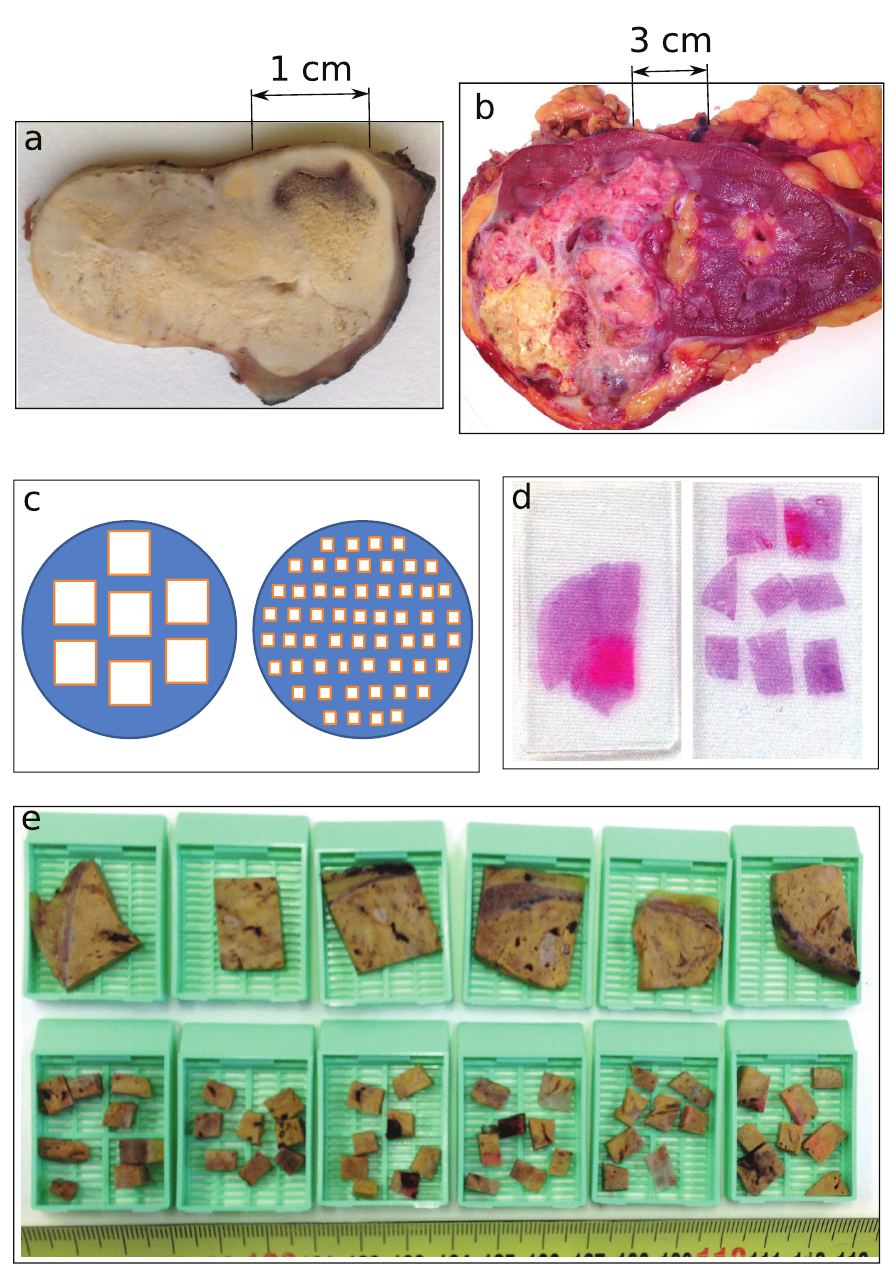
Figure 1. ITH in CCRCCs may be hidden ( a ) or evident ( b ) to the naked eye during the management of surgical specimens, an issue that is critical for subsequent tumor sampling. The RP strategy selects for the analysis 1 sample per cm of tumor diameter, as reflected at the left side of panels c – d ( c , diagram; d , histological slide) and at the top row of blocks in panel e . In contrast, the DAC strategy (the alternative we are suggesting here) selects more small-pieces for tumor sampling (for instance, panels c – e show how while RP selects big blocks, DAC selects 8 small-pieces per each large block) but the pieces are randomly chosen along the tumor. Importantly, both methods RP and DAC demand the same laboratory